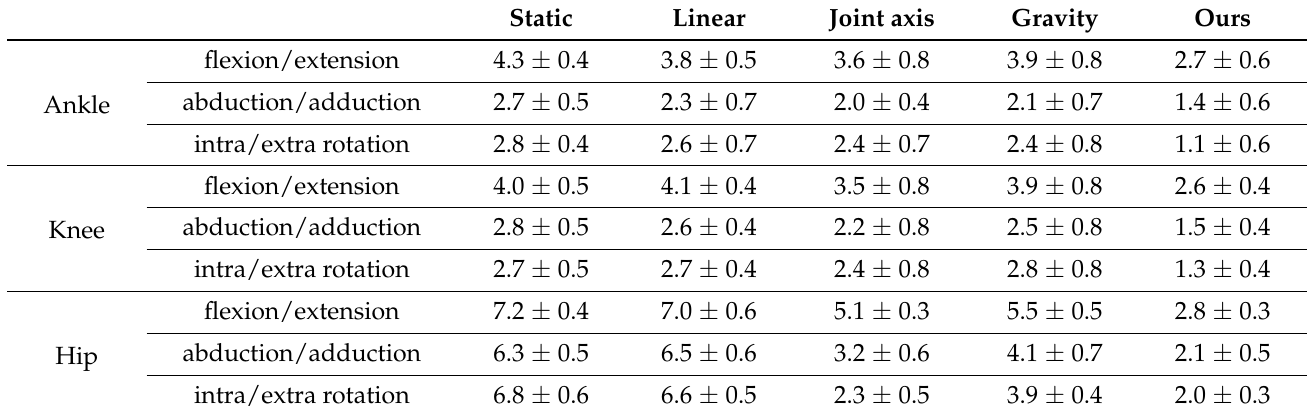
Figure 11. RMSEs of each joint and each dimension averaged over trials and subjects, where “static” denotes the static RFU method [28], “linear” denotes the linearly interpolted RFU method [23], “joint axis” denotes the joint axis-based RFU method [29], “gravity” denotes the gravity acceleration based method [13] and “ours” denotes the RFU method proposed in this paper, * denotes the significant difference analyzed by the one-way ANOVA ( α < 0.05). Table 1. RMSEs of each RFU methods.